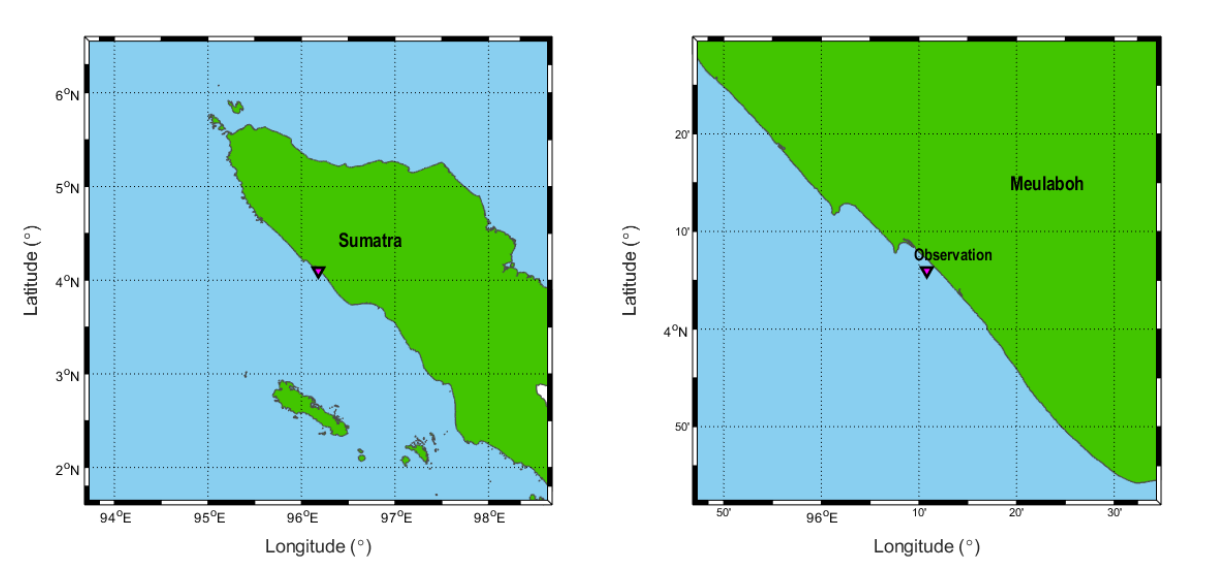
Figure 13. Location of wave observation at Meulaboh, West Aceh Regency,